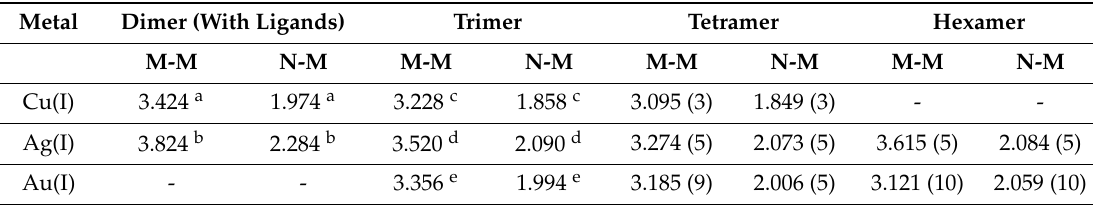
Table 3. Measured mean metal ··· metal and metal ··· N atom (Å) (averaged and parent pyrazoles).